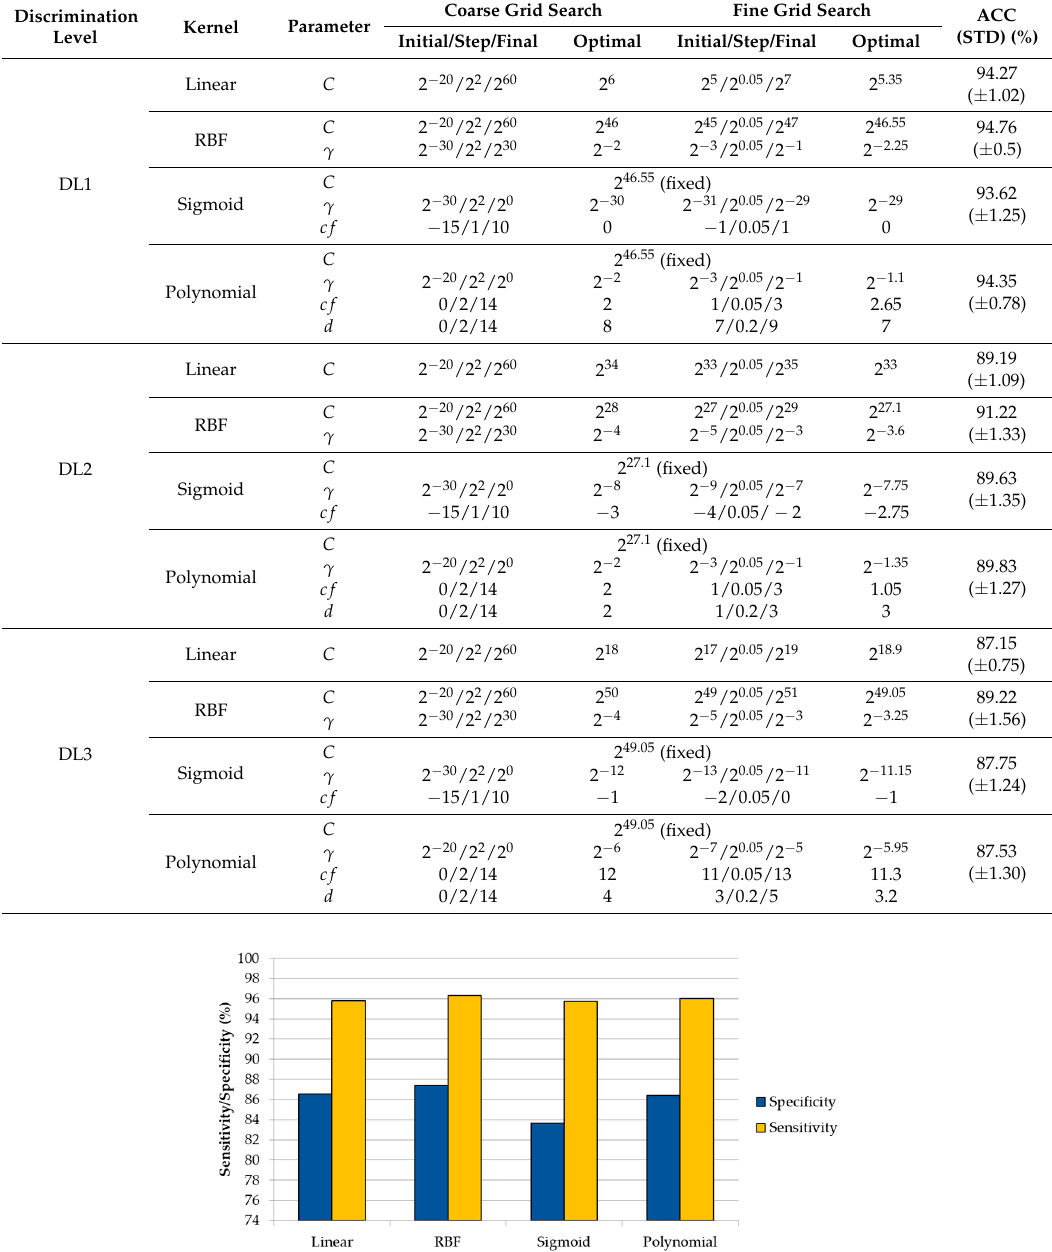
Table 3. Results of the hyperparameter tuning analysis for each discrimination level and SVM kernel. ACC: accuracy.